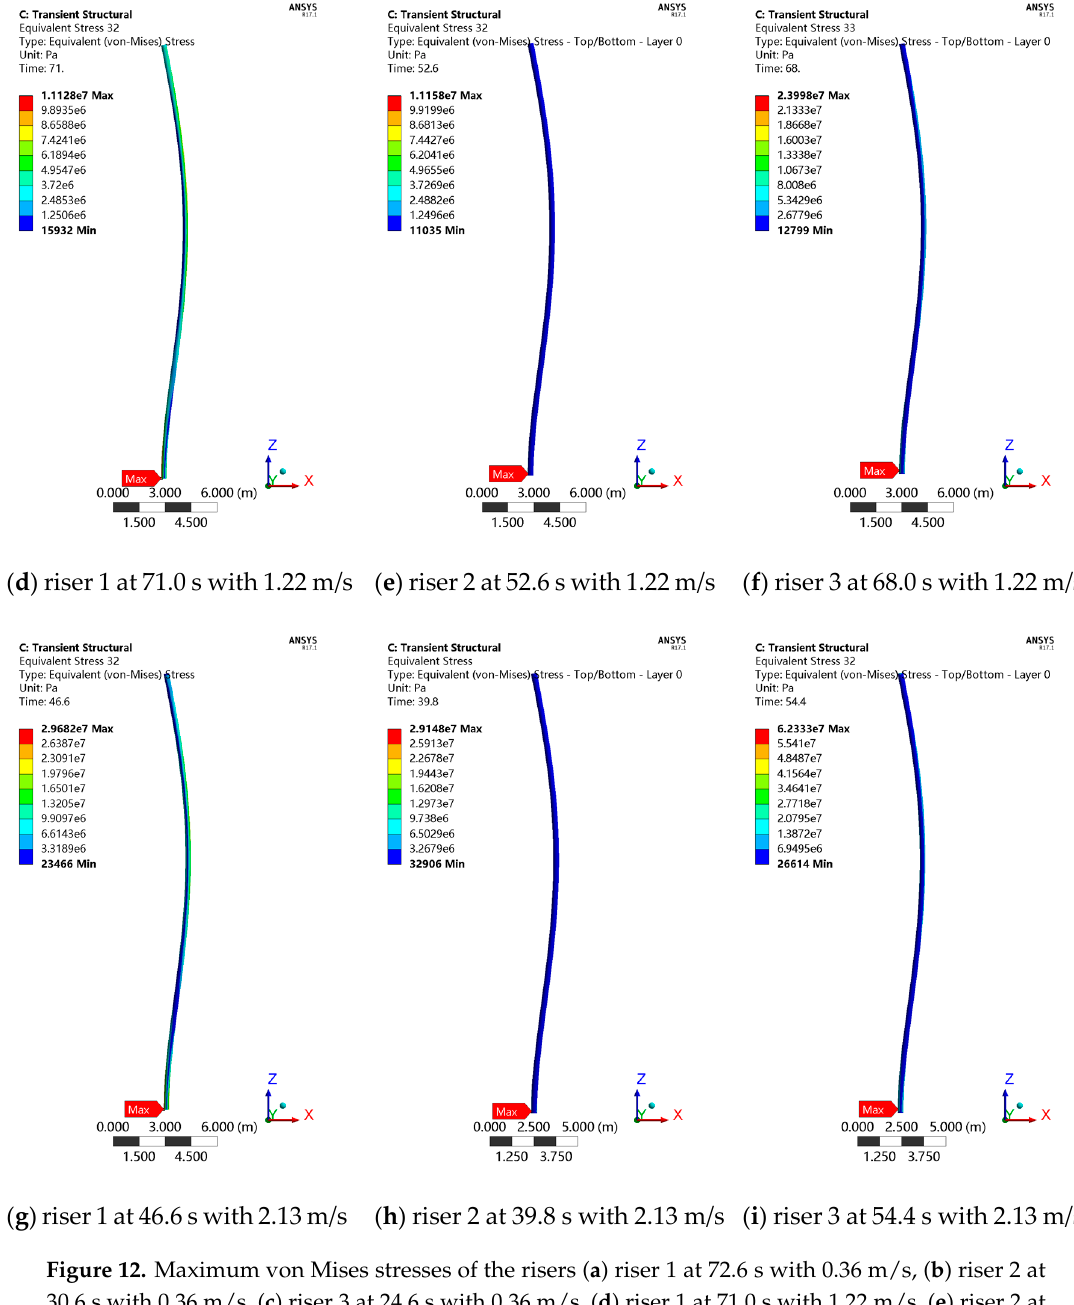
Figure 12. Maximum von Mises stresses of the risers ( a ) riser 1 at 72.6 s with 0.36 m/s, ( b ) riser 2 at 30.6 s with 0.36 m/s, ( c ) riser 3 at 24.6 s with 0.36 m/s, ( d ) riser 1 at 71.0 s with 1.22 m/s, ( e ) riser 2 at 52.6 s with 1.22 m/s, ( f ) riser 3 at 68.0 s with 1.22 m/s, ( g ) riser 1 at 46.6 s with 2.13 m/s, ( h ) riser 2 at 39.8 s with 2.13 m/s, ( i ) riser 3 at 54.4 s with 2.13 m/s.